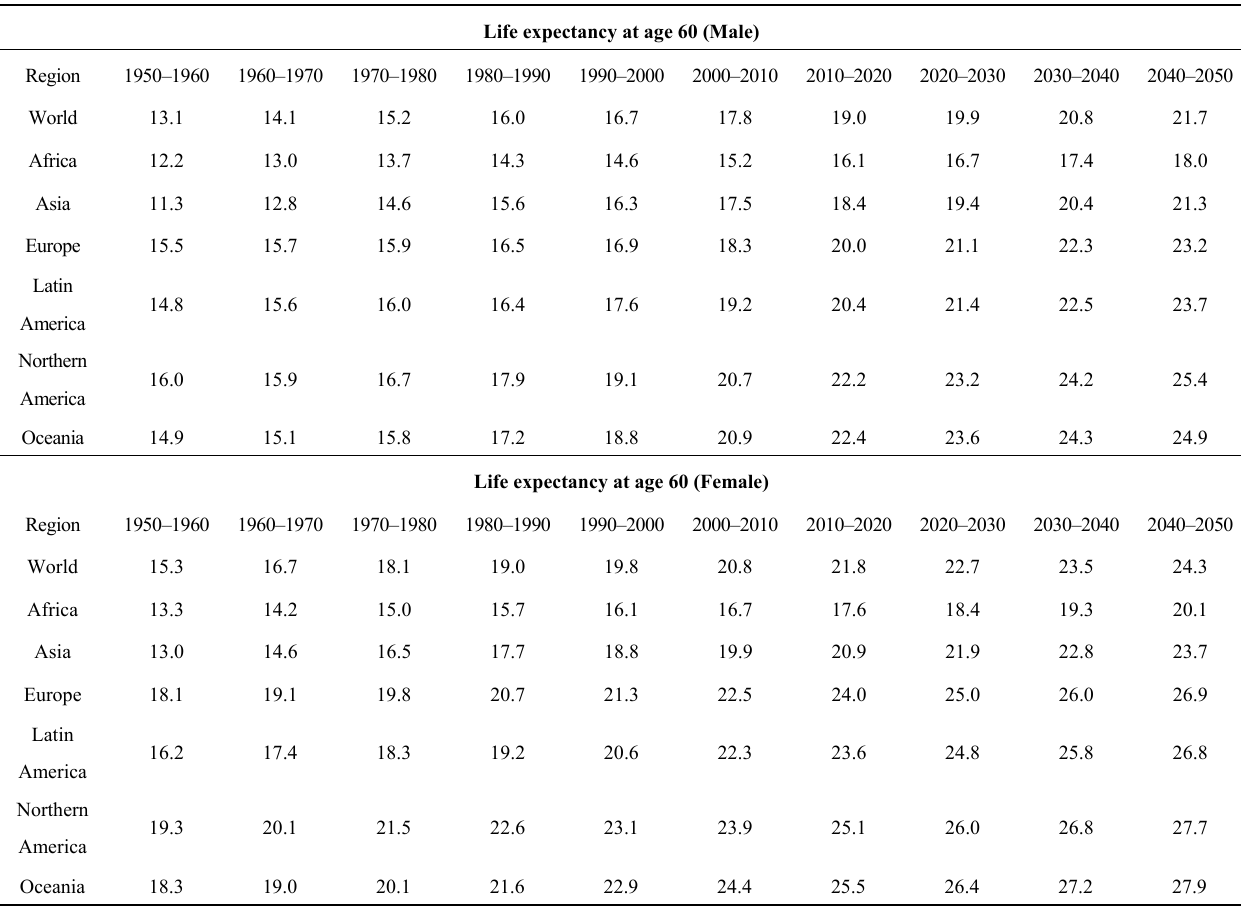
Table 1. Life expectancy at age 60 in the world and six regions. Life expectancy at age 60